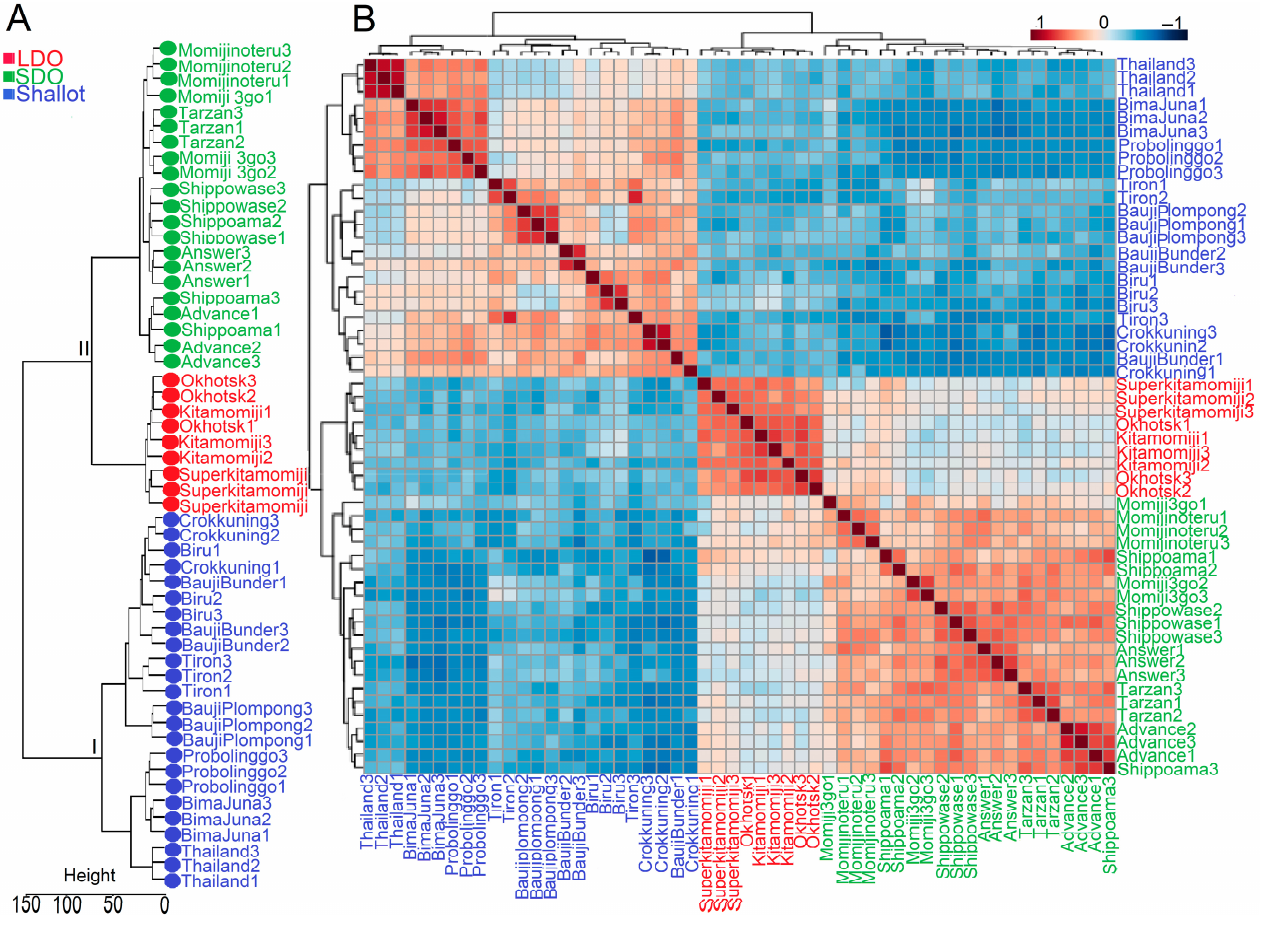
Figure 3. Dendrogram clustering and Pearson correlation heatmap of the investigated Indonesian shallot landraces and Japanese long-day and short-day onions (LDOs and SDOs, respectively) genotypes grown under normal growth conditions. ( A ) Dendrogram clustering of the investigated genotypes using 172 metabolite variables. The height of the bar indicates the distance between the clusters. ( B ) Heatmap of the Pearson correlation of the investigated genotypes based on metabolite variables. Color scale indicates Pearson correlation coefficients.